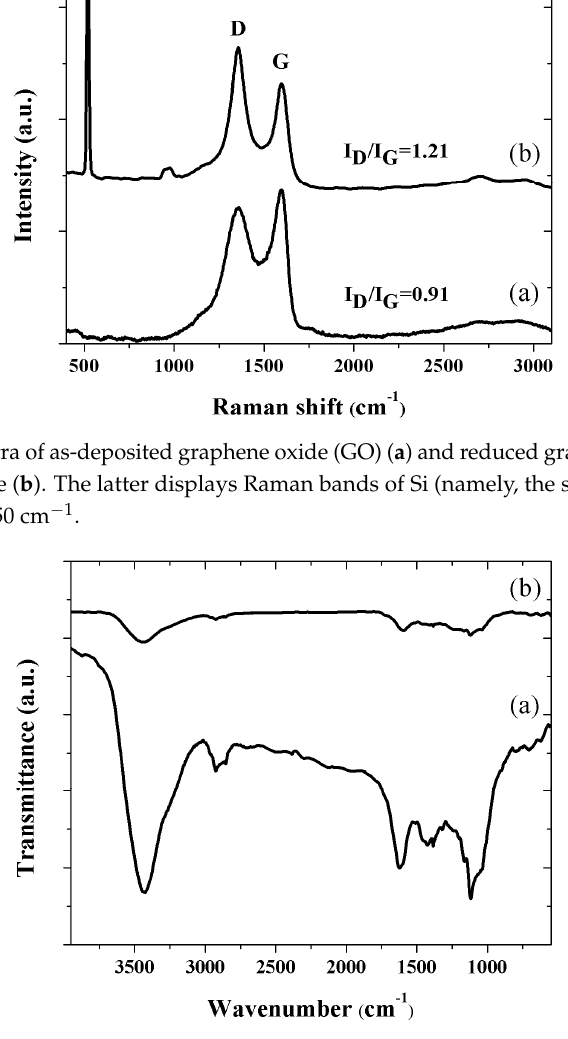
Figure 2. FT-IR spectra of ( a ) as-deposited GO and annealed sample at ( b ) 1000 °C for 1 h.